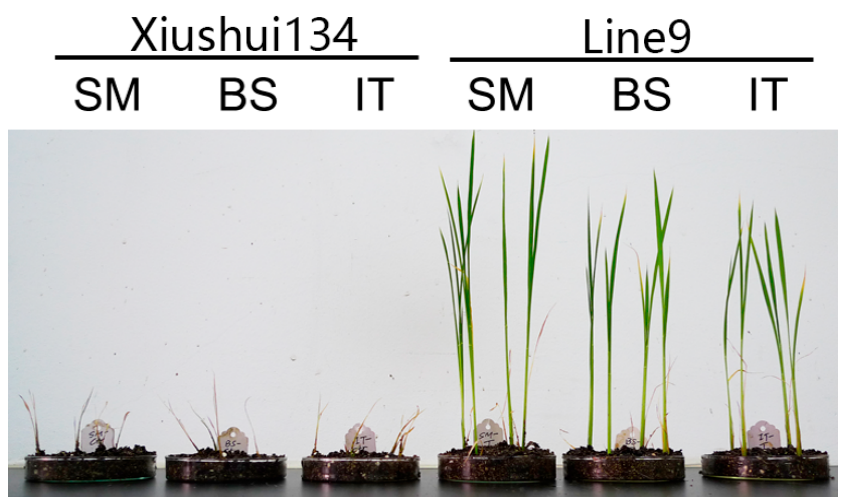
Figure 7. Image showing rice plants with herbicide treatment. The plants were treated with 0.25 g/L SM, 0.8 g/L BS or 2.2 g/L IT at the seedling stage. After two weeks, the Xiushui134 plants withered, while the Line9 plants survived with the herbicide treatment.